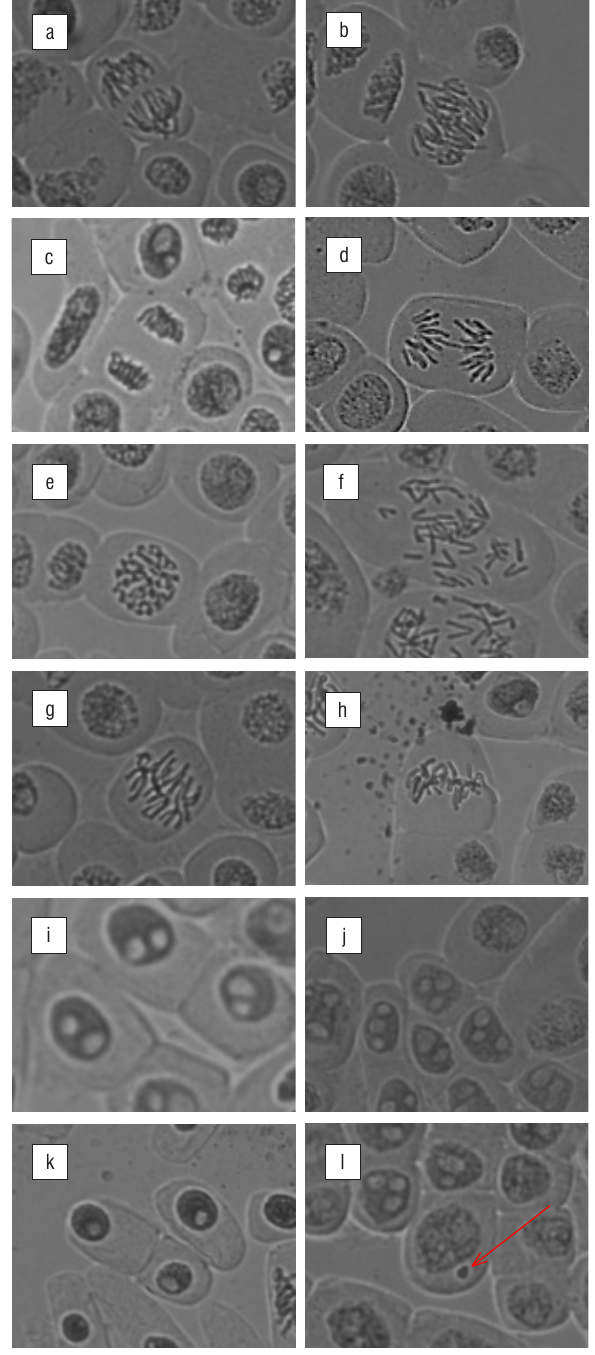
Figure 1: Chromosome aberrations observed in Allium cepa meristematic cells exposed to water extracts of Tulbaghia violacea: (a) normal anaphase, (b) laggard chromosome, (c) normal telophase, (d) chromosome bridge, (e) normal prophase, (f) c-mitosis, (g) metaphase anaphase, (h) sticky chromosomes, (i) binucleus, (j) trinucleus, (k) normal interphase and (l) micronucleus indicated by arrow. The presence of micronuclei (l) was observed in the roots treated with the different extracts of T. violacea and most were significantly different ( p <0.05) when compared with the negative control (Table